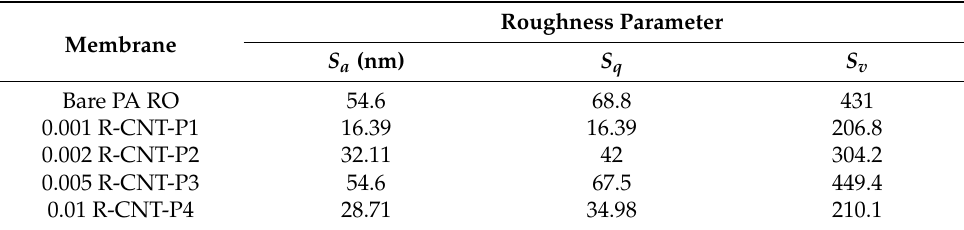
Table 1. The roughness analysis of the surface by DME/APM.